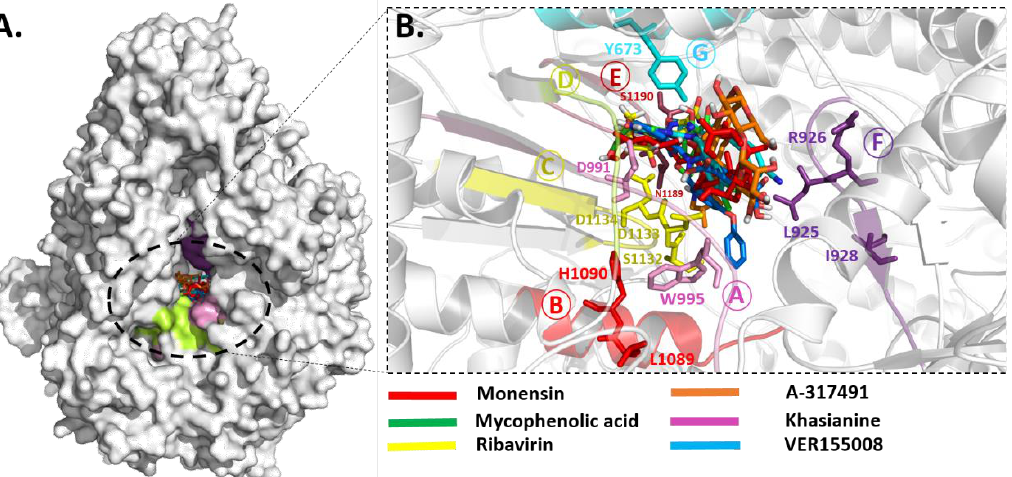
Figure 5. Binding modes of compounds . ( A ) Molecular surface representation for the inhibitory binding pattern of all ligands. ( B ) Close-up view into the binding mode of all compounds within the active site of RdRp core. The main residues involved in the formation of the active site within the structurally conserved RdRp motifs that are shown in stickes.